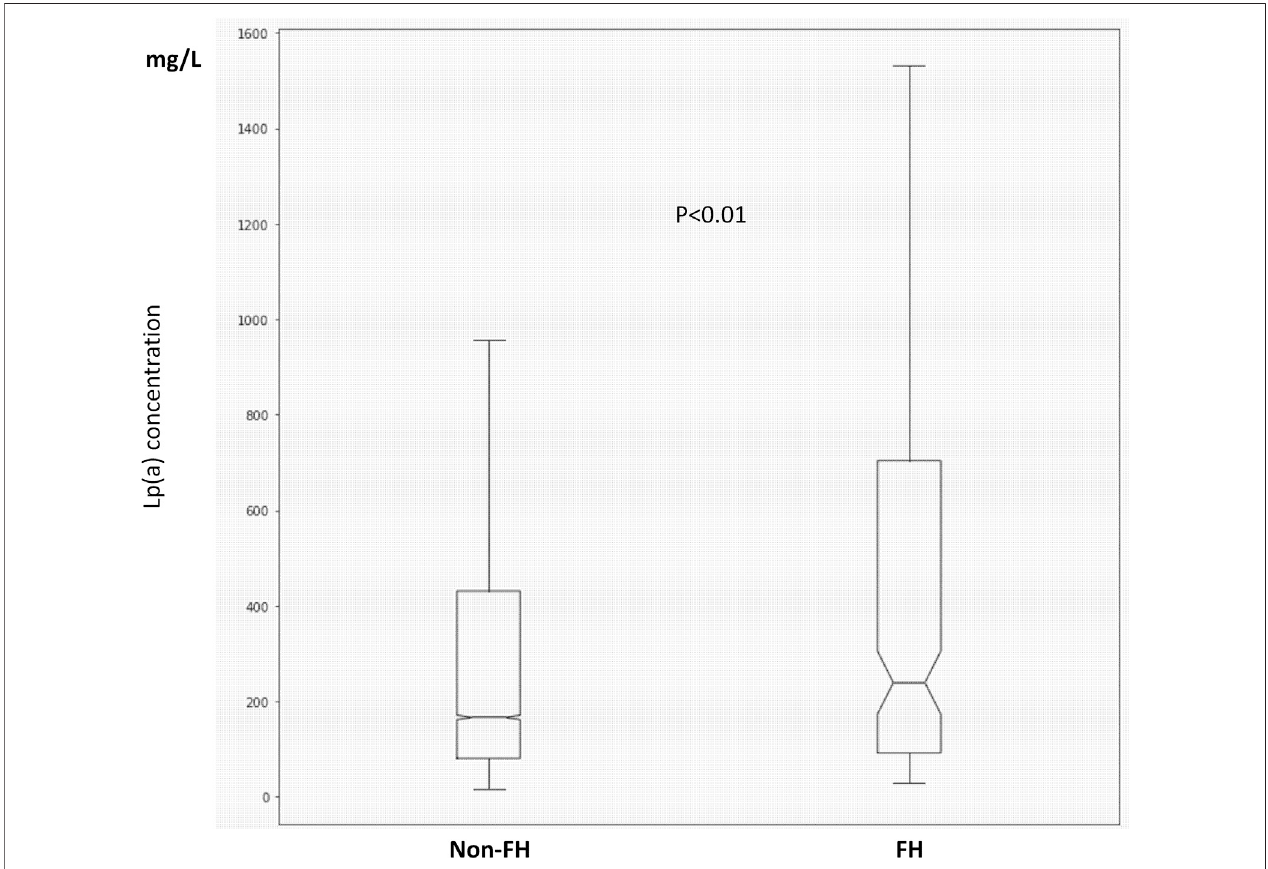
FIGURE 2 | Boxplots and whiskers of serum lipoprotein(a) levels in FH and non-FH patients. The length of the box represents the interquartile range (IQR), the horizontal line in the box interior represents the median, the whiskers represent the 1.5 IQR of the 25th quartile or 1.5 IQR of the 75th quartile.